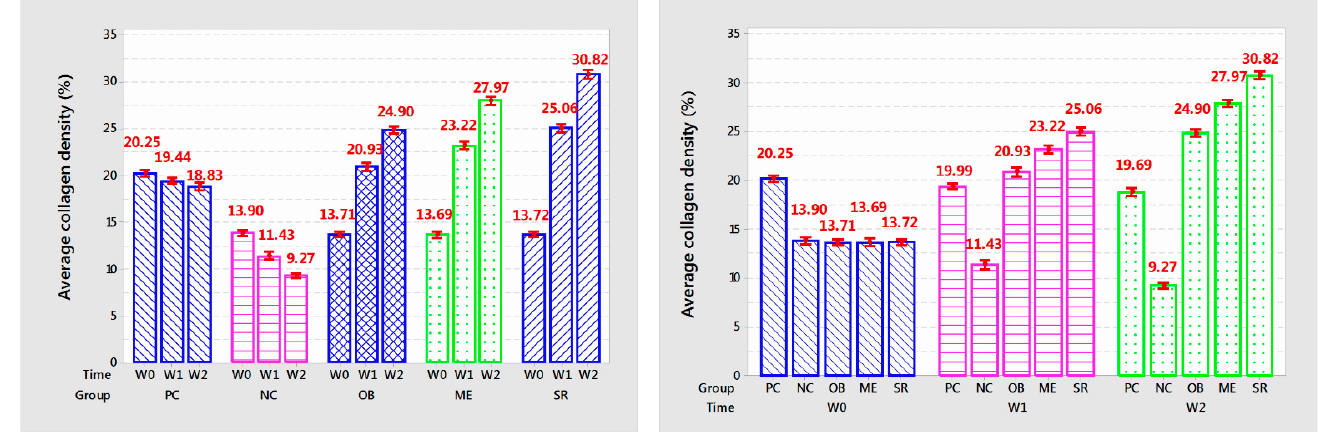
Figure 8. The graph shows the average collagen density (%) of the mouse skin after each week of